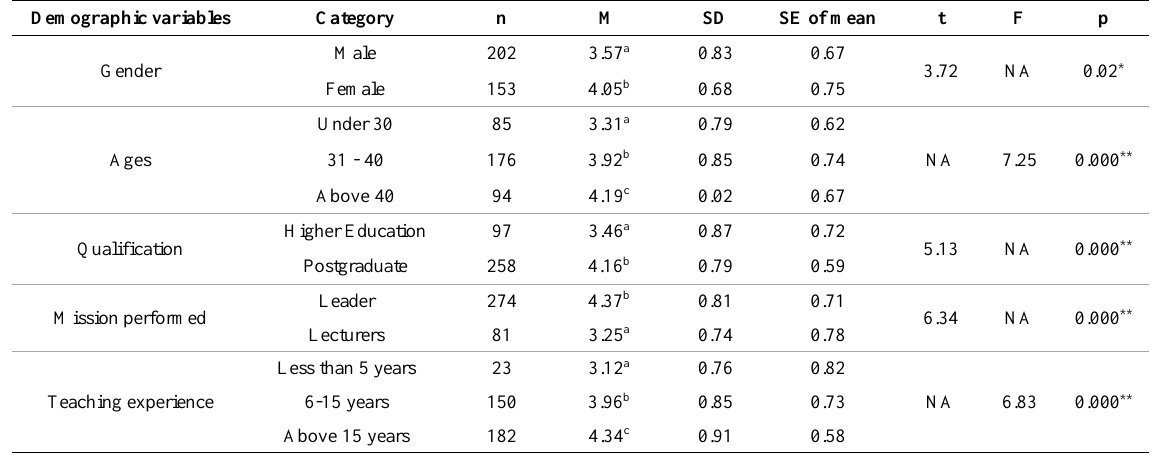
Table 5. Leadership style assessment results by demographic characteristics